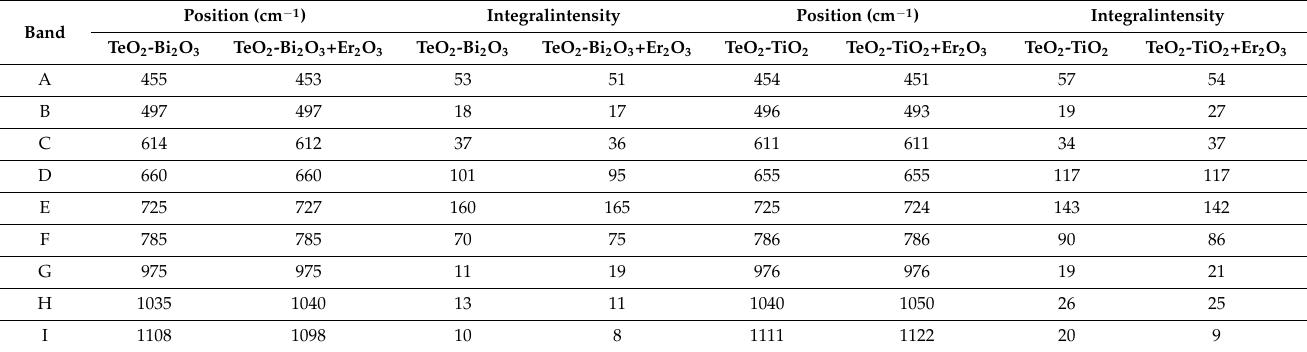
Figure 7. Deconvoluted Raman spectra of S5 and S6 glasses. Table 4. Component band’s parameters of Raman spectra of S3–S4 pairs and S5–S6 pairs of Table 3. Component band’s parameters of Raman spectra of S1 and S2 glasses.